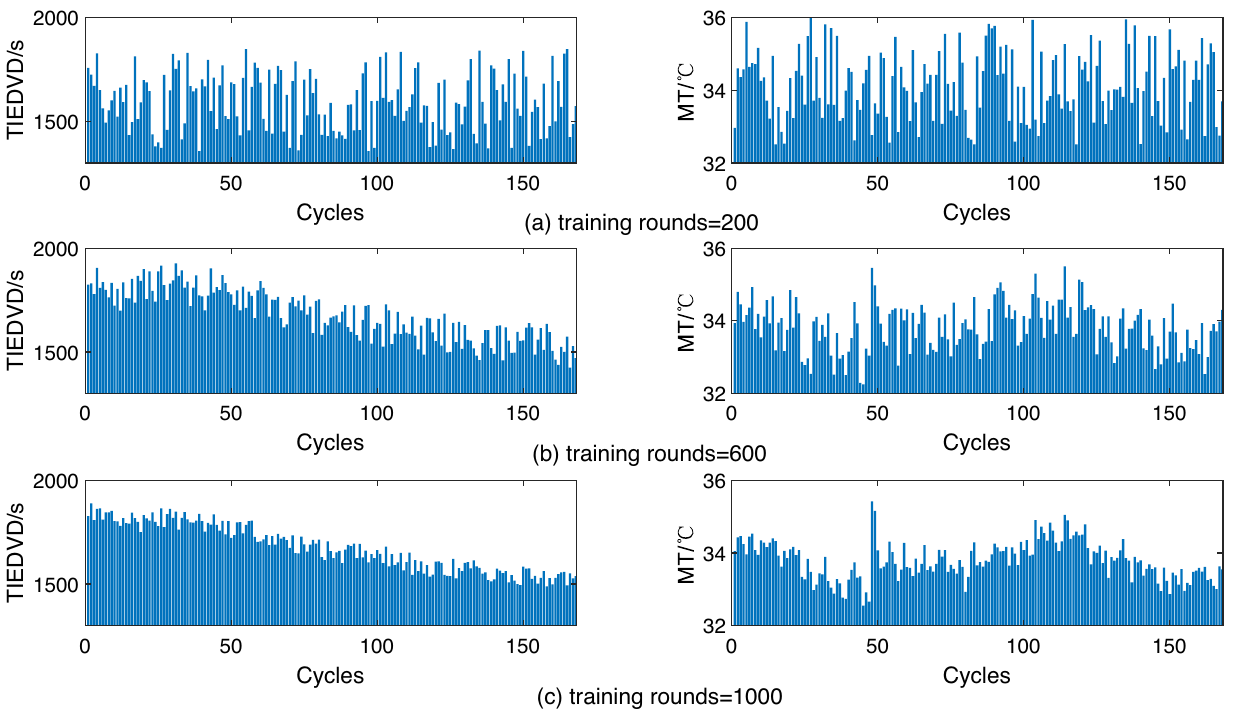
Fig. 6 The distribution of simulated data generated by GAN with the training rounds of 200, 600, and